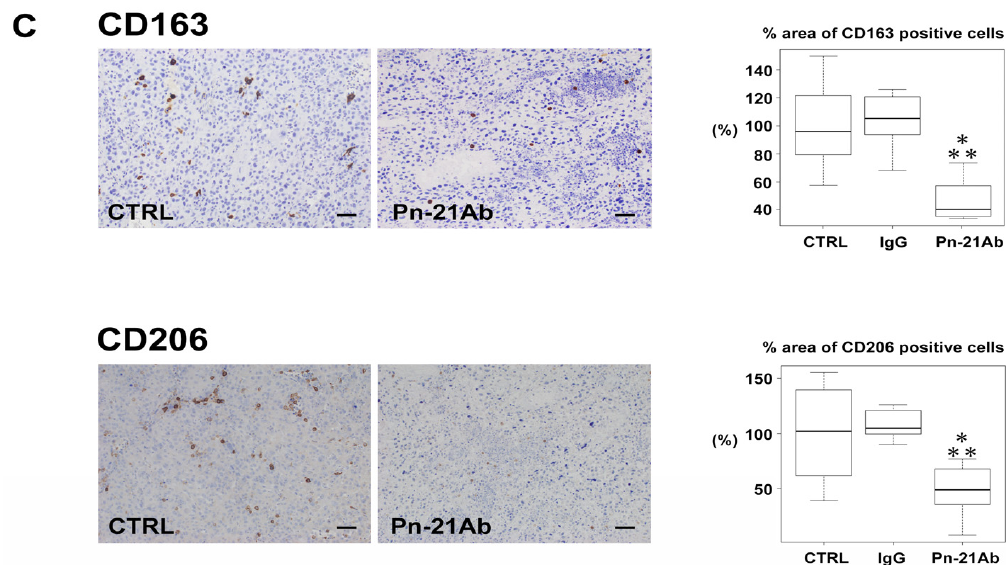
Figure 4. Disrupting Pn ASV with Pn-21 Ab reduces M2 tumor-supportive TAMs in vivo. Immunohistochemical or immunofluorescent staining with the pan macrophage marker (Iba1) ( A ), M1 macrophage marker (CD11c) ( B ), and M2 macrophage markers (CD163 and CD206) ( C ) in SUM159PT double-positive cell xenografts. Tumors were collected at day 36. Scale bars represent 50 µ m. Box plot showing a significant reduction in M2 TAM density in Pn-21 Ab treated xenografts ( n = 6–7). The TAM marker-positive area of tumors was quantitated in at least 4 view fields per tumor by using Image J program. *** p < 0.05 vs. CTRL, IgG, respectively. p values were calculated by using the one-way ANOVA test and Tukey–Kramer’s post hoc test.